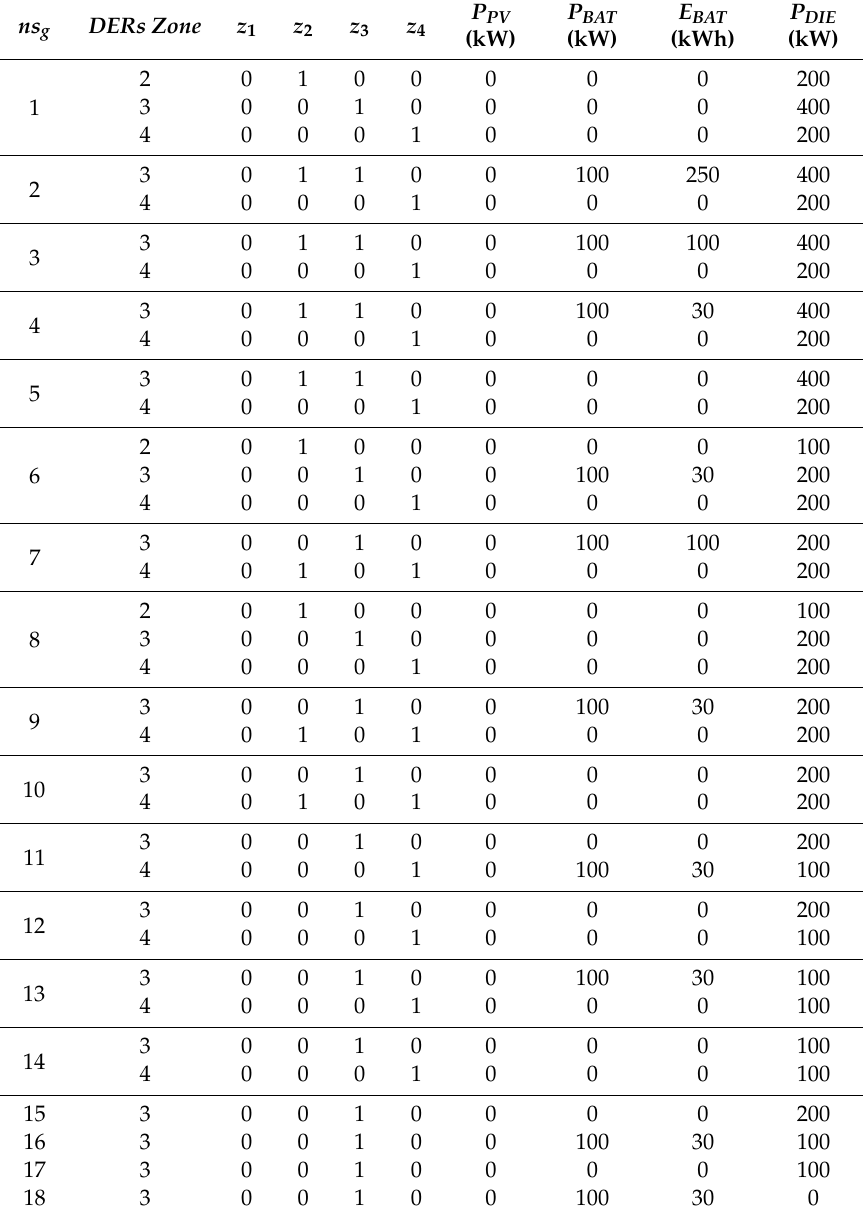
Table 6. Optimal network solutions for the case study